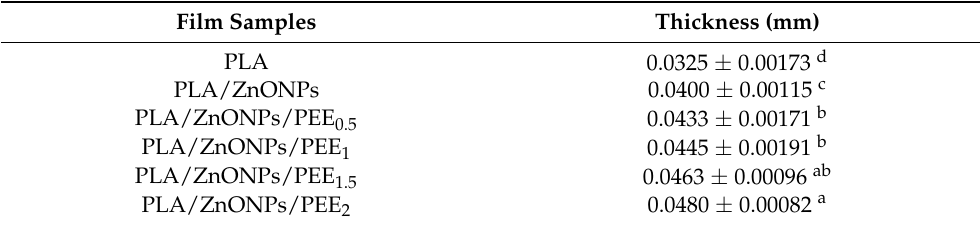
Figure 4. ( a ) Tensile strength and elongation at break, ( b ) water contact angle, ( c ) moisture content and water solubility, ( d ) water vapor permeability of PLA based composite films. Different letters in the same column indicate significant differences between the films (p < 0.05). Table 1. Thickness of polylactic acid (PLA) based composite